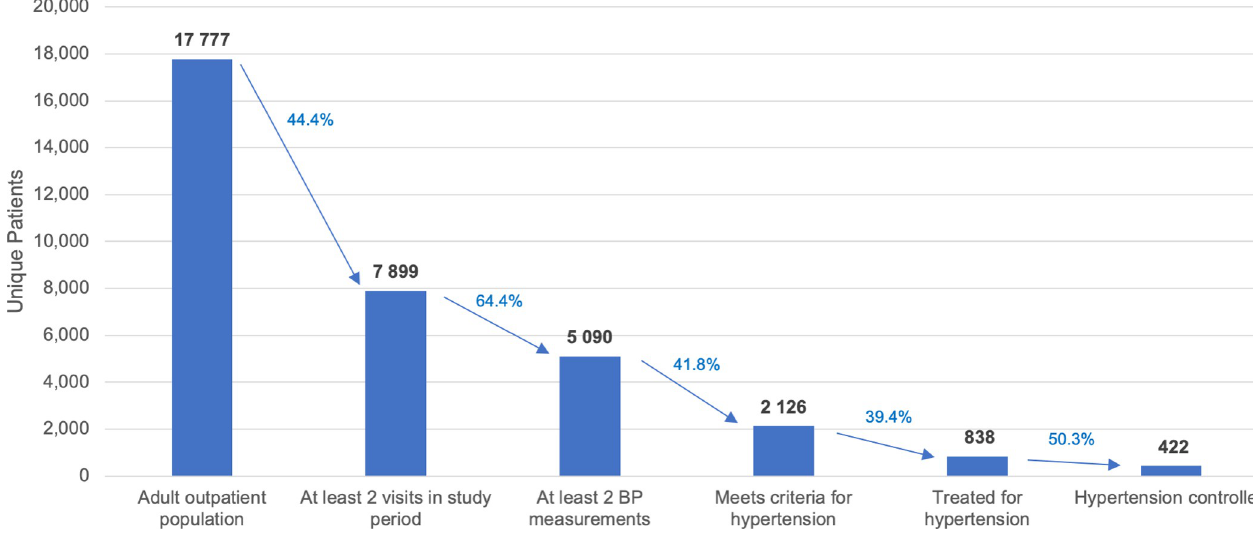
Fig 2. Cascade of care. Bars in graph depict extent of correct, and imperfect, treatment and control across steps of care cascade. https://doi.org/10.1371/journal.pgph.0000386.g002 pressure measurements ( Table 2 ). The age-standardized prevalence of hypertension in this sample was 33.4%. Among 2 121 patients, 1 915 met hypertension criteria by blood pressure measurements, 838 by receipt of antihypertensive therapy, and 668 by EMR code. See S1 Fig for a Venn diagram comparing the different hypertension criteria included in the evaluation of prevalence. Of the 2 085 patients who had hypertension by blood pressure or receipt of anti- hypertensive medications, 632 (30%) were diagnosed as hypertensive by EMR code. 36 patients had a ‘hypertension’ EMR code alone. Overall, older patients had higher rates of hypertension prevalence than younger patients (79% in 66+, as compared to 23% among ages 18–30), as did male patients (46%) when com- pared to female patients (38%). In a multiple logistic regression describing hypertension preva- lence and its correlates, older age (OR 1.06, 95% CI 1.05–1.06, p < 0.001), male gender (OR